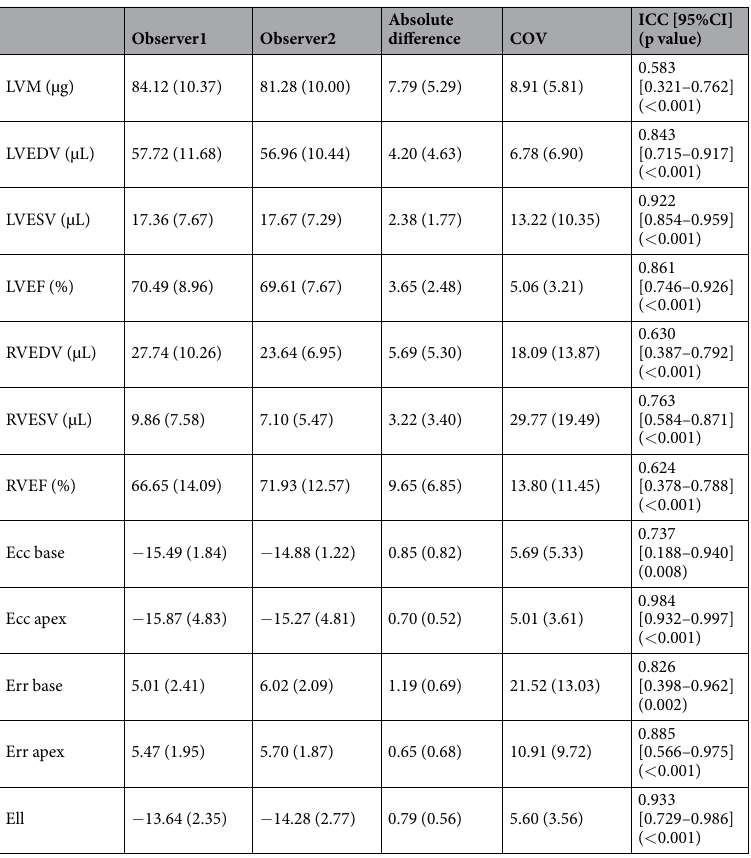
Table 4. Inter-observer reproducibility as evaluated by the absolute difference, coefficient of variation (COV) (expressed in %) and interclass correlation (ICC) between results from the first (observer1) and second (observer2) observers who post analyzed the same CMR examinations. Data are the mean (SD) except for ICC [95% interval confidence] (p